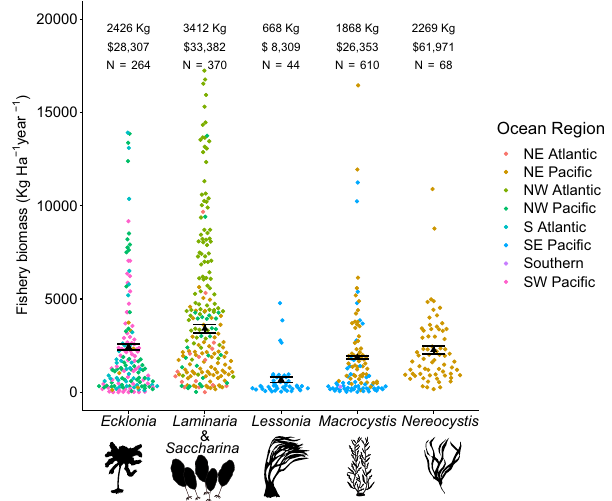
Fig. 1 | Fisheries biomass and associated economic value provided by kelp forests. Site (unique time and location) yearly total biomass and the economic value of the harvestable fi sheries production per hectare per year. The values are represented for each kelp genus, colours represent the ocean region, the black triangle and number values represent the mean value for the genus, the error bars arethestandarderror.Note:thesamplesizerepresentsthenumberofpointsused for calculation, though 70 – 90% of points for Ecklonia, Laminaria & Saccharina (previously classi fi ed as Laminaria in some regions), and Macrocystis have been randomly removed from the graph for better visualization. Image credit: Tim Carruthers,IntegrationandApplicationNetwork(ian.umces.edu/media-library)for the Ecklonia , Laminaria, Lessonia, Macrocystis, Nereocystis